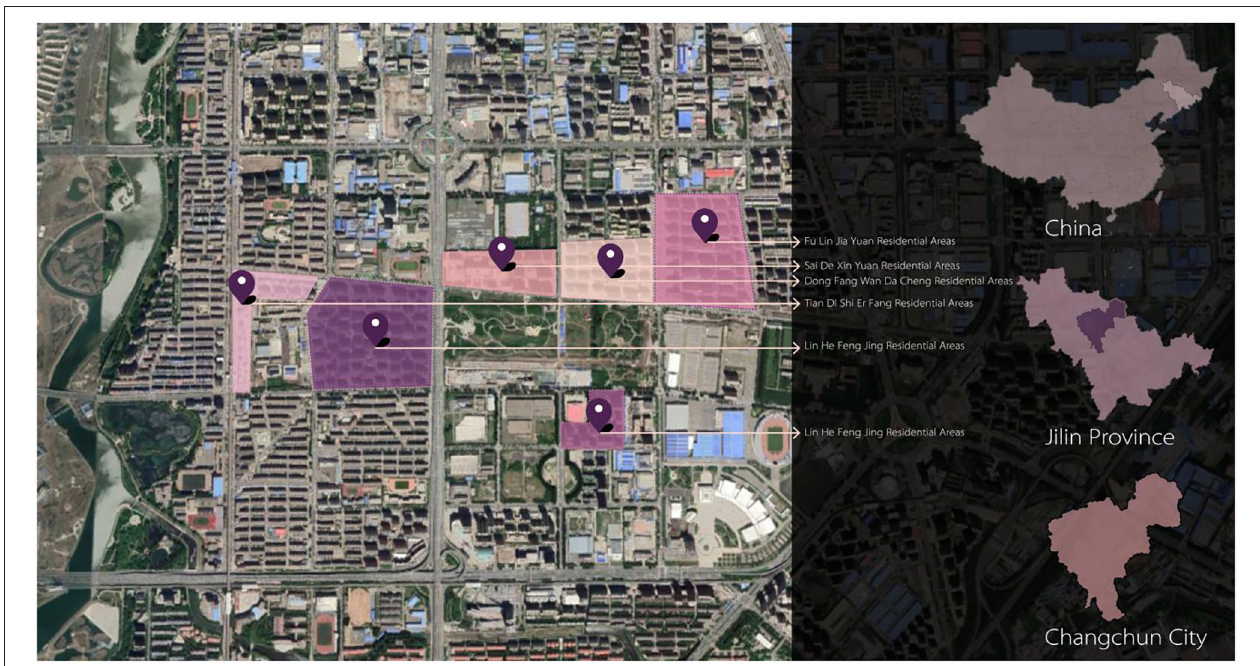
FIGURE 1 | Location and scope of the